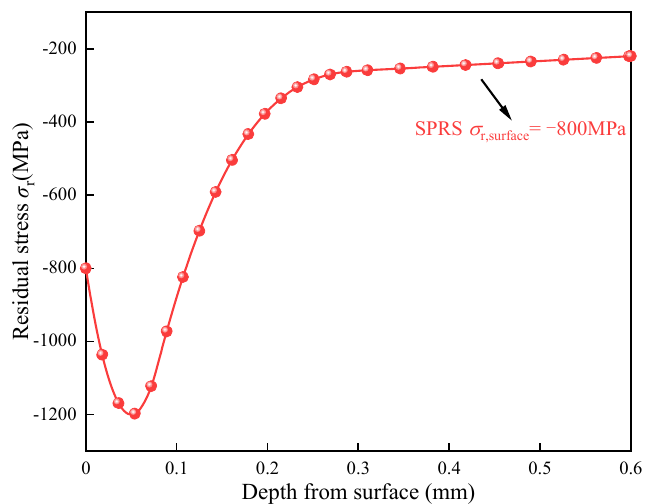
Figure 11. The residual stress distributions induced by shot peening.